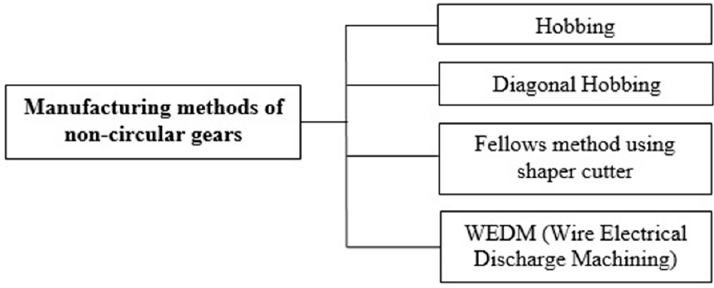
Figure 5. Manufacturing methods of non-circular gears.